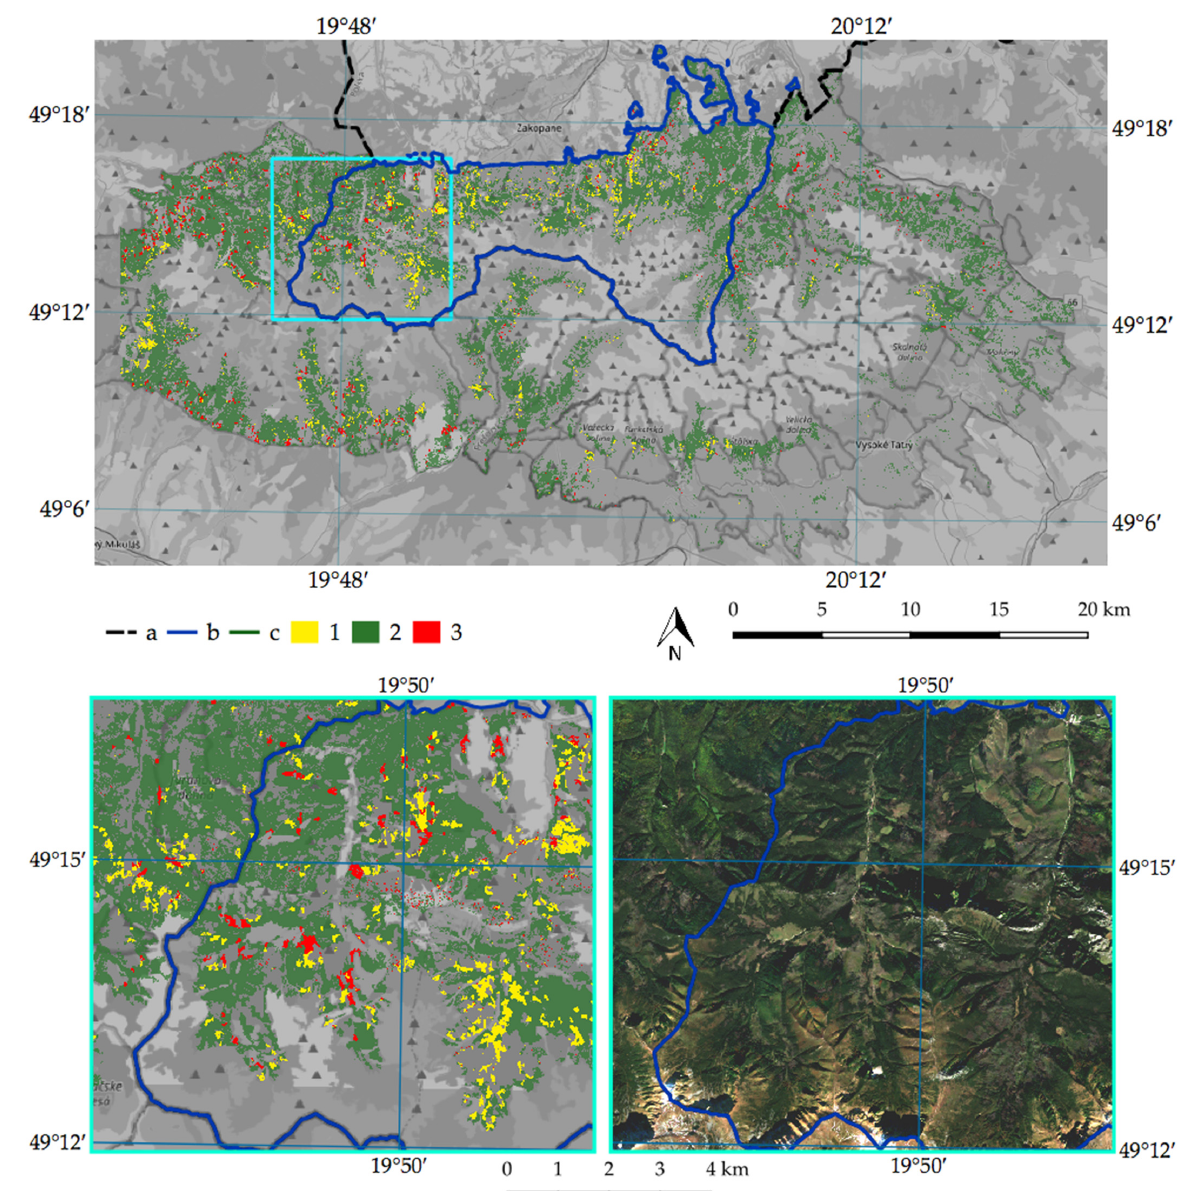
Figure 6. Map of the bark beetle outbreak in 2017 for the Tatras: (a) country border; (b) border of the Polish TPN; (c) border of the Slovak TANAP; (1) snags; (2) undisturbed coniferous forest; (3) cuts or windthrow areas. A map from OpenStreetMap was used in the background and Sentinel-2 RGB 432 composition acquired on 2 October 2017.